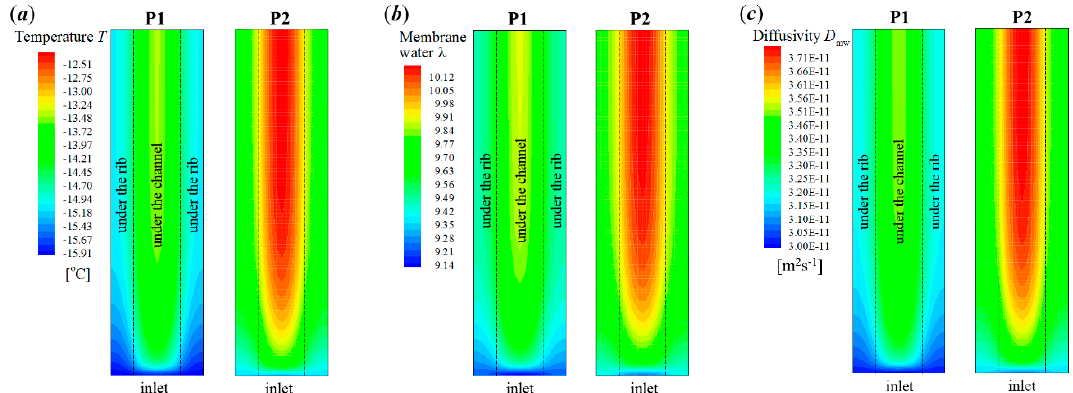
Figure 10. Contours of ( a ) temperature, ( b ) membrane water content, and ( c ) membrane water diffusivity in the middle plane of CCL (XZ plane with Y = − 0.01 mm) for the process P1 and P2 at the time 1.6 s later than the occurrence of freezing. The cell starts from − 20 °C with initial membrane water content λ 0 = 5.0 and current density I 0 = 0.30 A/cm 2 . The cell is supplied with dry hydrogen and oxygen. The stoichiometry ratio of the mass flow rate is 2.0 for both anode and cathode sides. The background pressure is 1.0 atm at both the anode and cathode